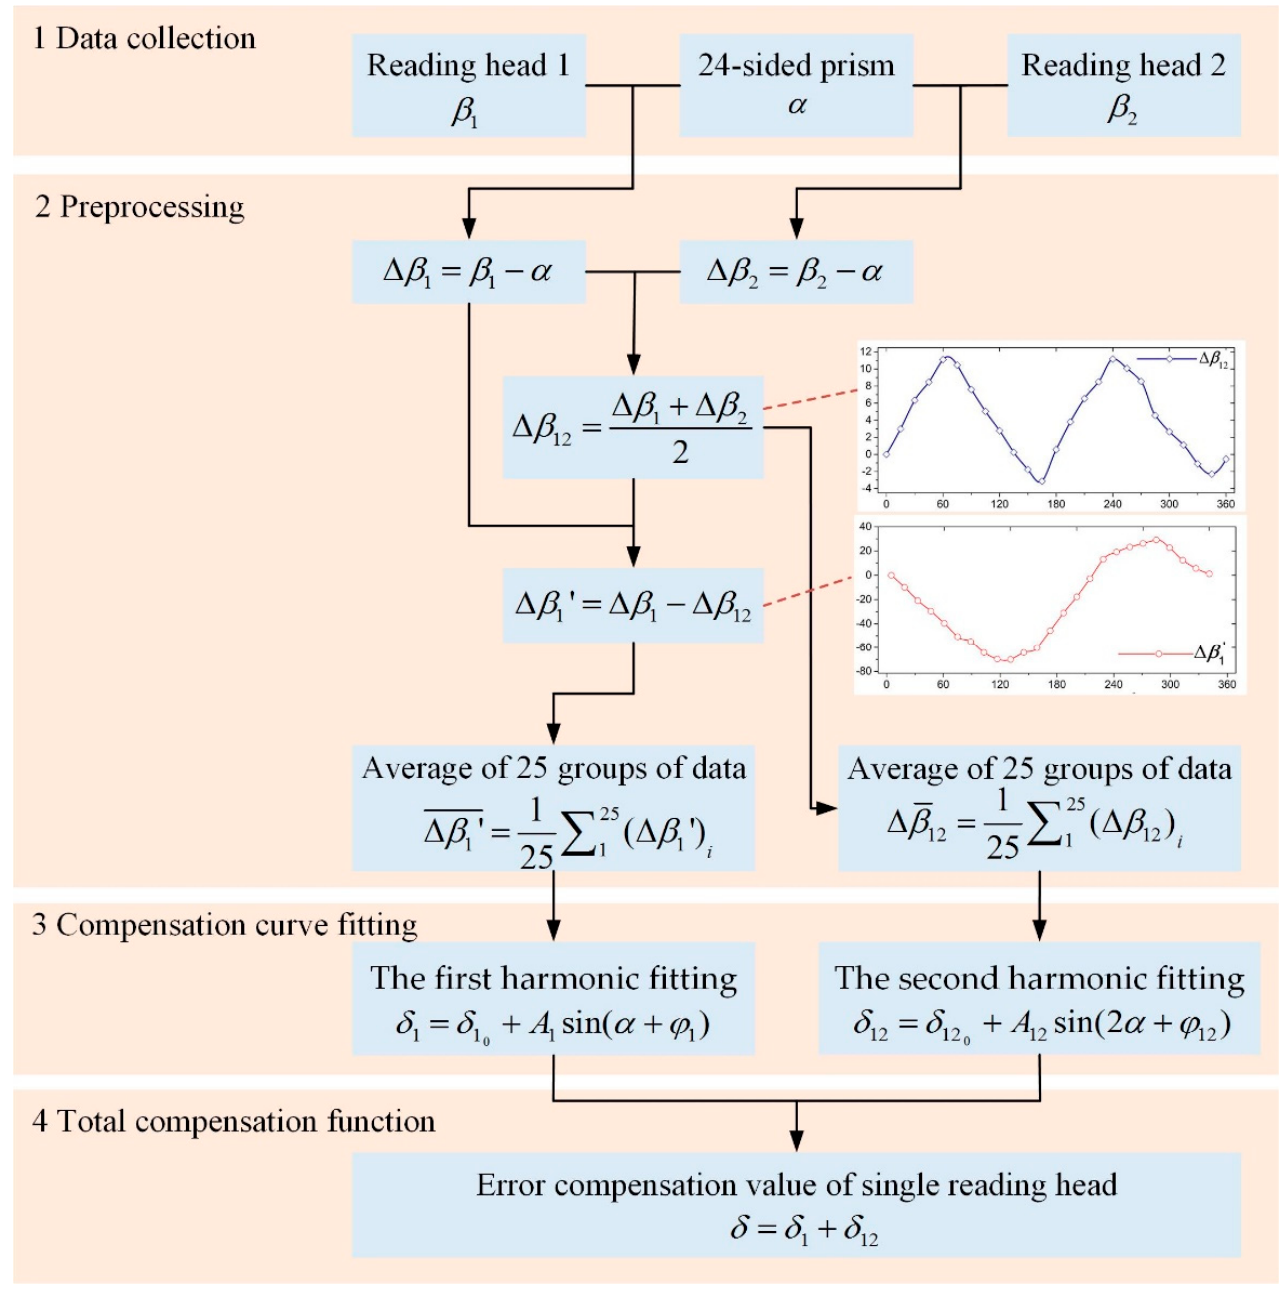
Figure 8. Calibration steps of the angle measurement error of the single reading head. According to the initial phases ϕ 1 and ϕ 12 of the fitting function and the position of the shaft corresponding to the 0th side of the prism, the initial flag of the error compensation could be determined. Then, in the experiment, according to the error compensation functions, starting from the initial flag, the angle measurement error of one revolution of the shafting could be compensated. To each group of measurement data, the compensation function β 1 * and the residual error v 1 after the compensation of reading head one were,